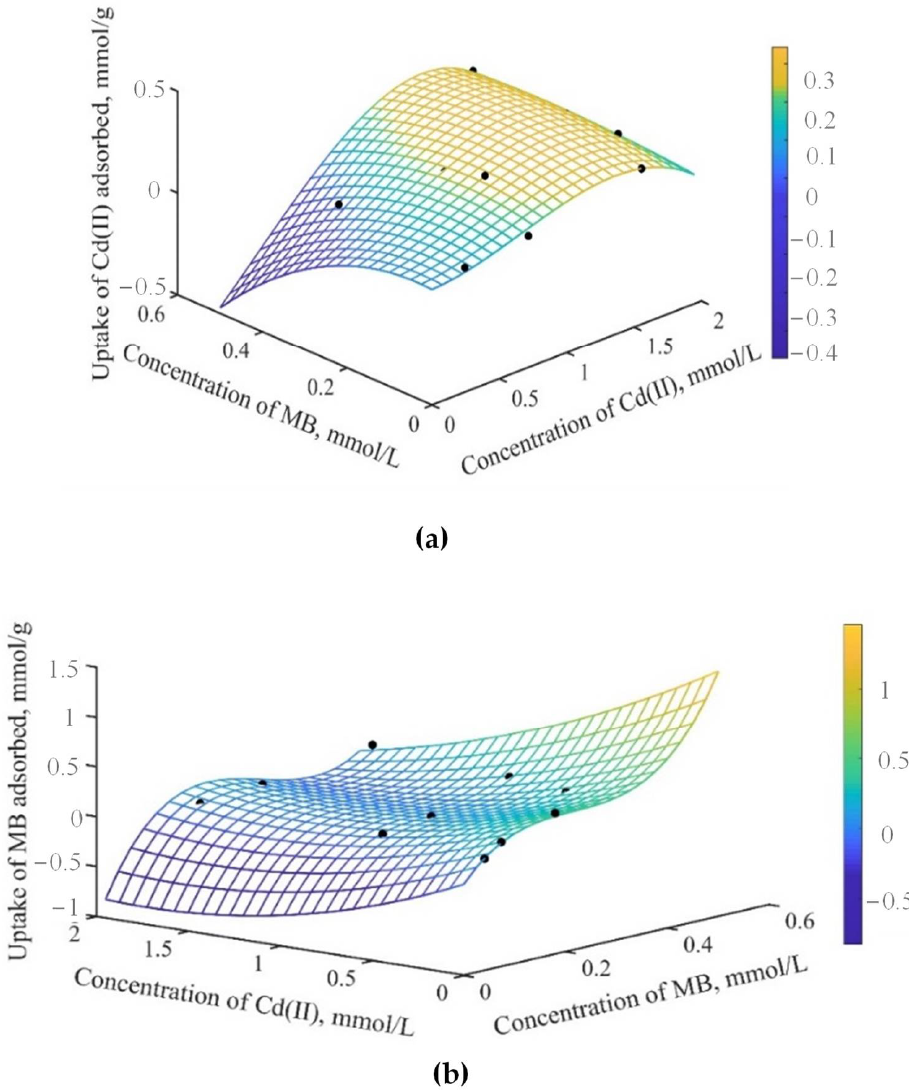
Figure 4. Effect of the equilibrium concentration of pollutants in multicomponent systems. ( a ) Ad- sorption capacity for Cd 2+ in the presence of MB. ( b ) Adsorption capacity for MB in the presence of Cd 2+ .